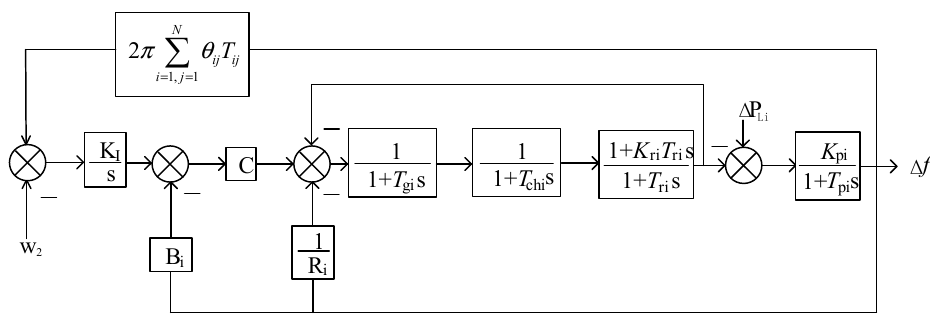
Figure 1. Frequency control system model of the TPU. Table 1. Variable Table.